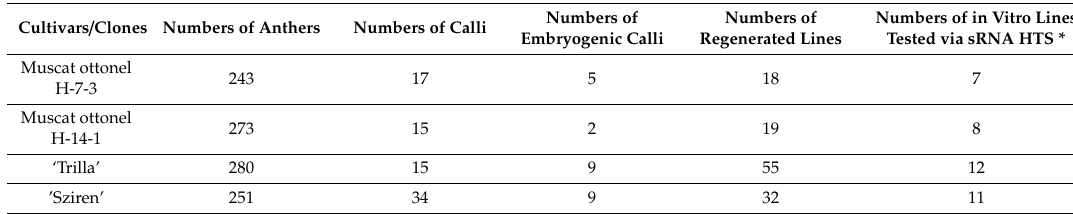
Table 3. Results of the somatic